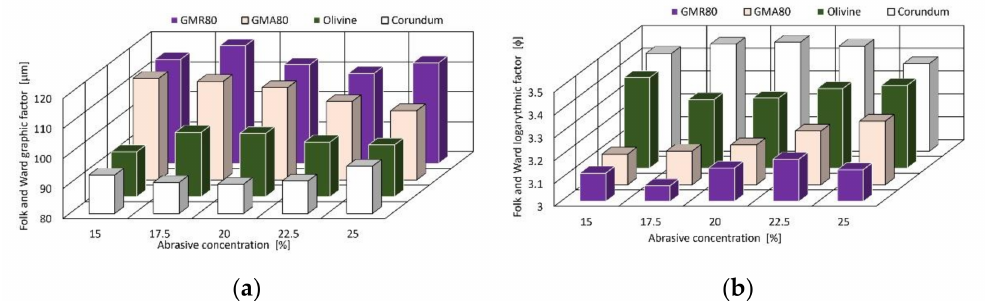
Figure 7. Folk and Ward sample means distribution factors: ( a ) graphic; ( b ) logarithmic.